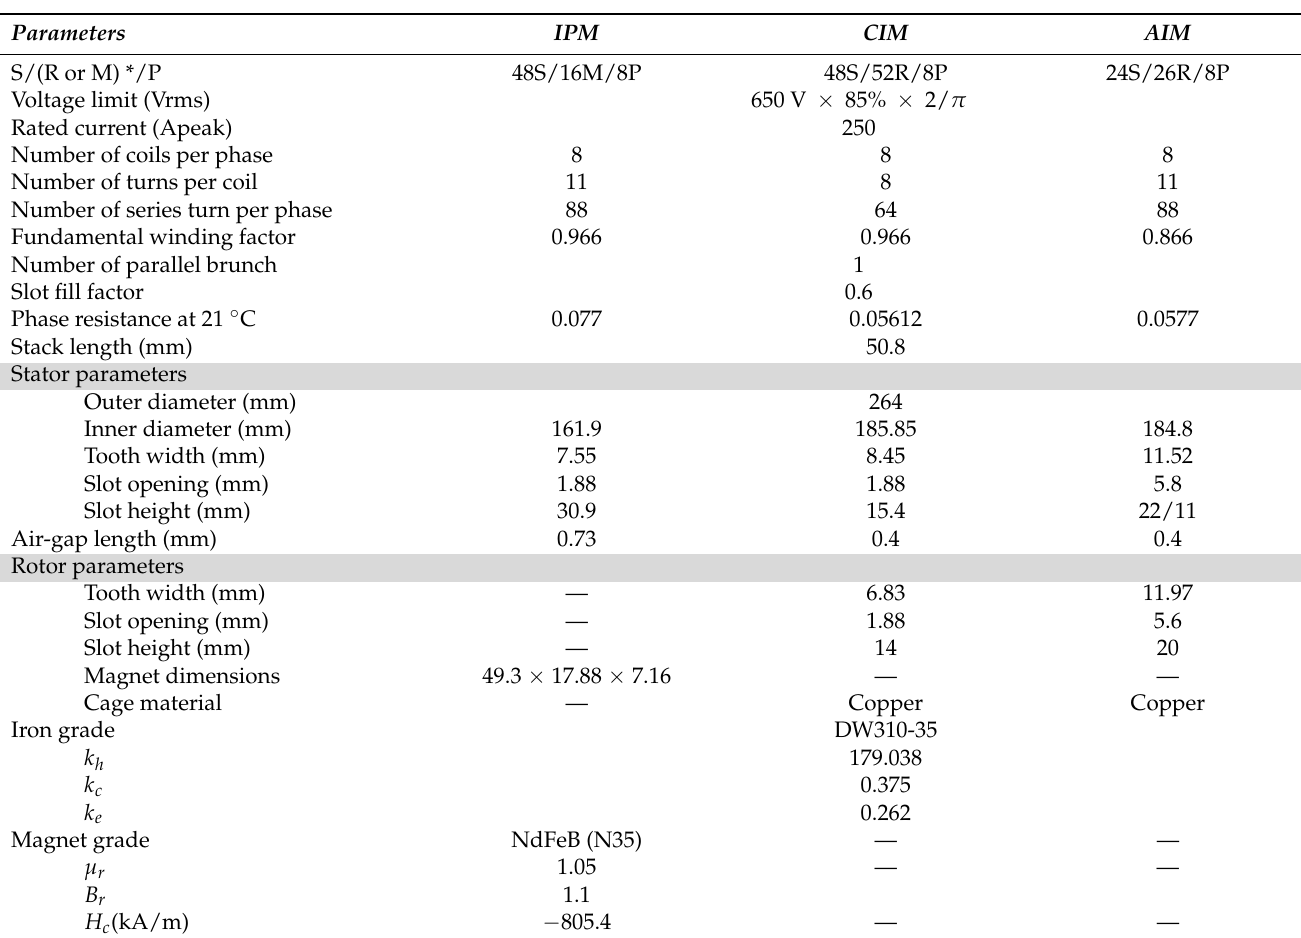
Table 2. Specifications of Prius IPM machine and IMs.